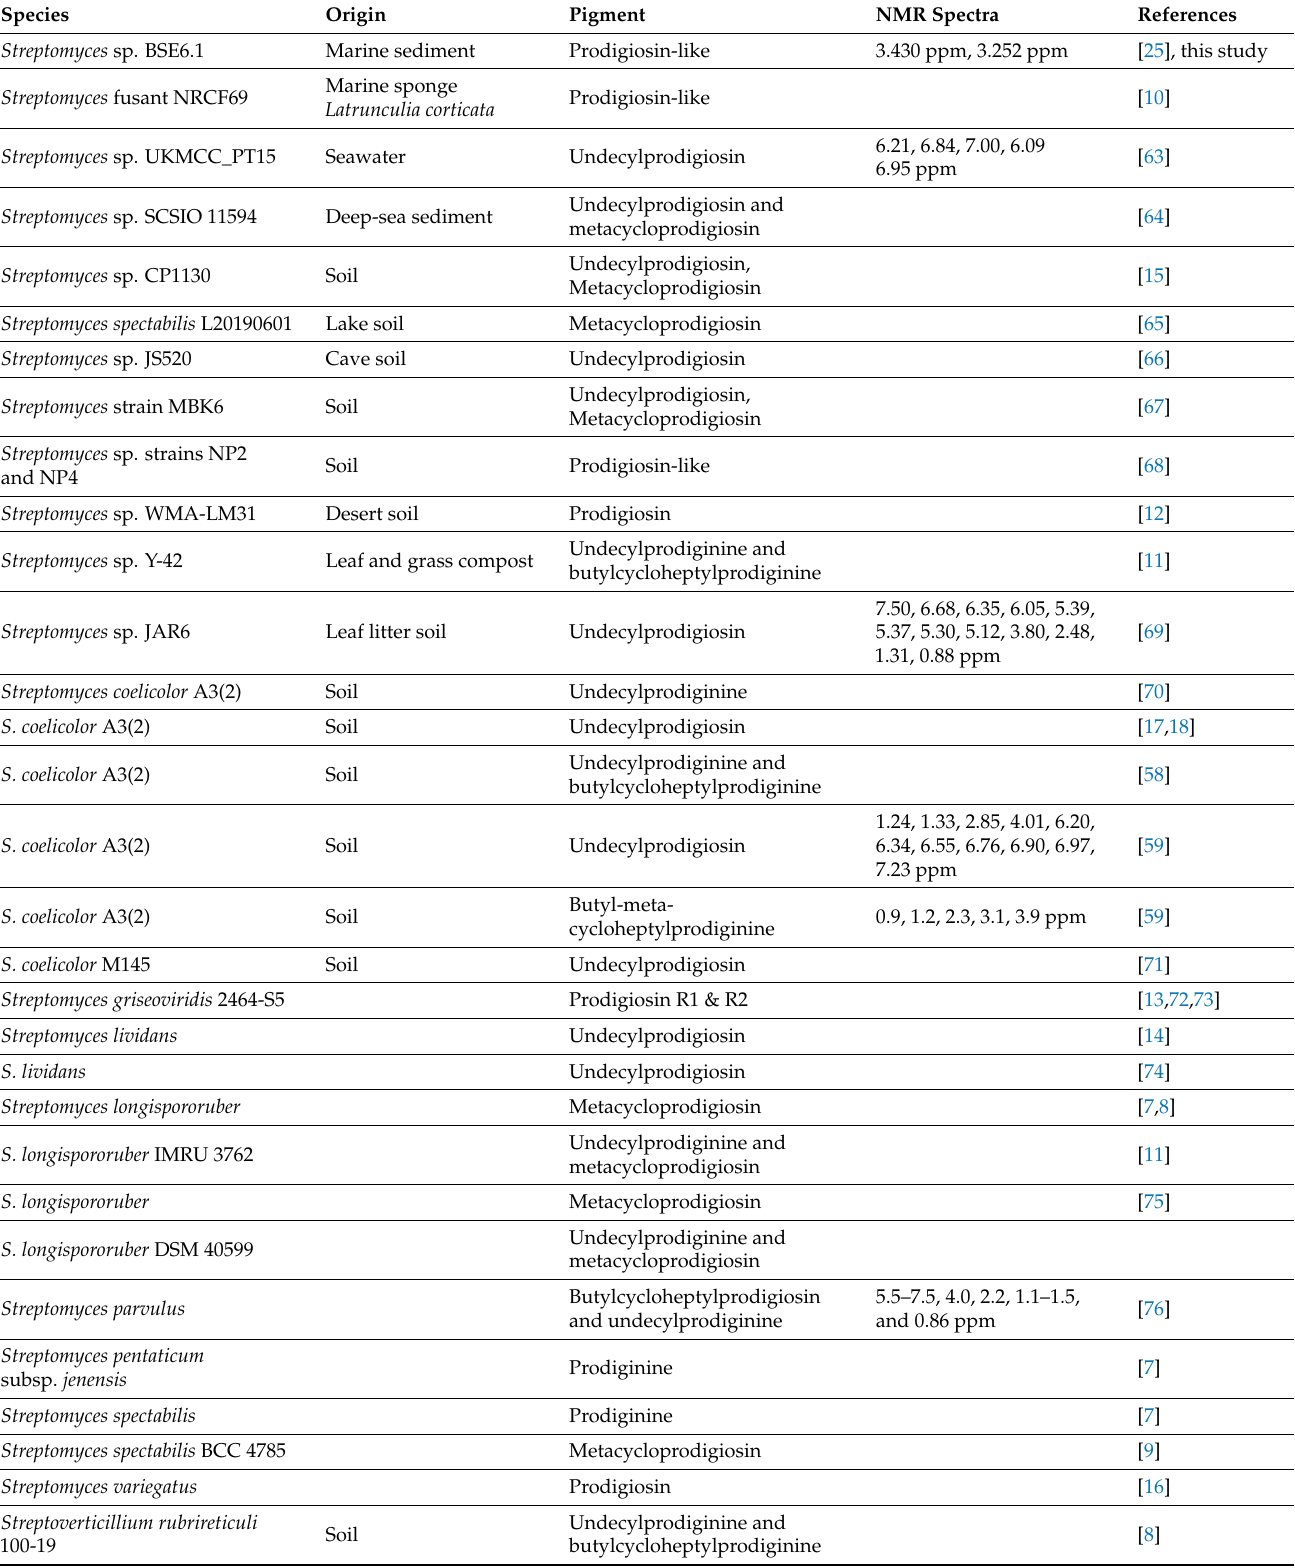
Table 1. Details of various Streptomyces species capable of producing prodiginine